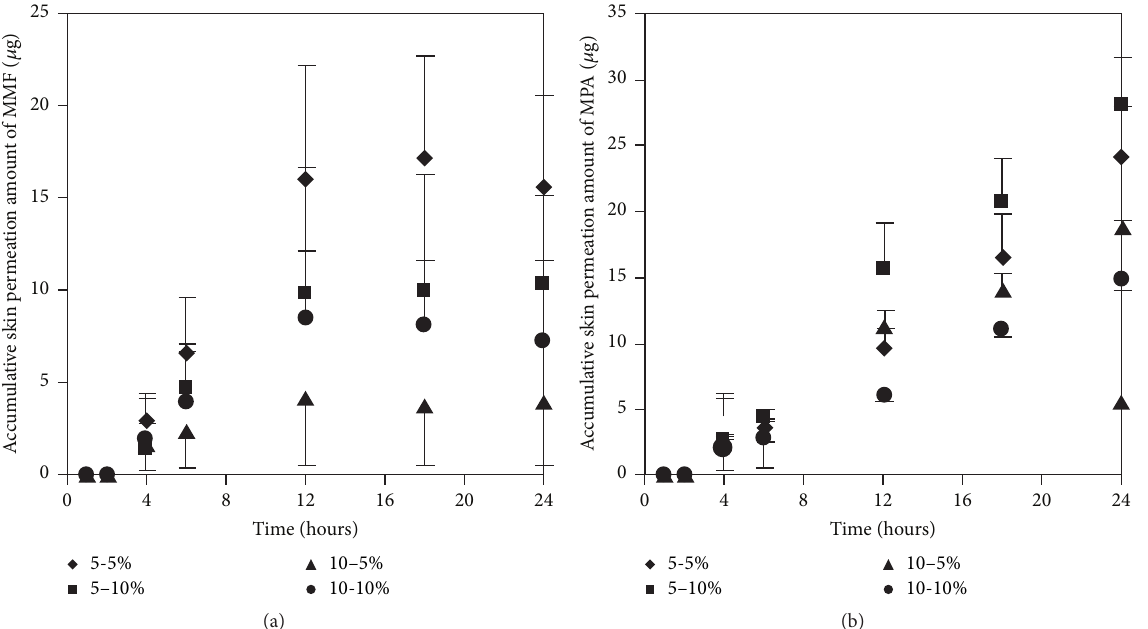
Figure 7: Skin permeation profiles of MMF (a) and MPA (b) at various concentration ratios of mixed enhancers between EUL and NMP incorporated to 300 𝜇 g/mL of MMF